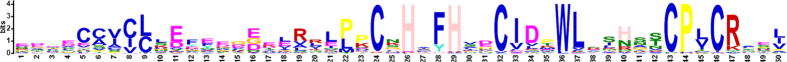
Sequence LOGO of the VviATL RING-H2 domains.The LOGO was generated from the protein sequences of the 96 ATLs identified in the whole Vitis vinifera genome.